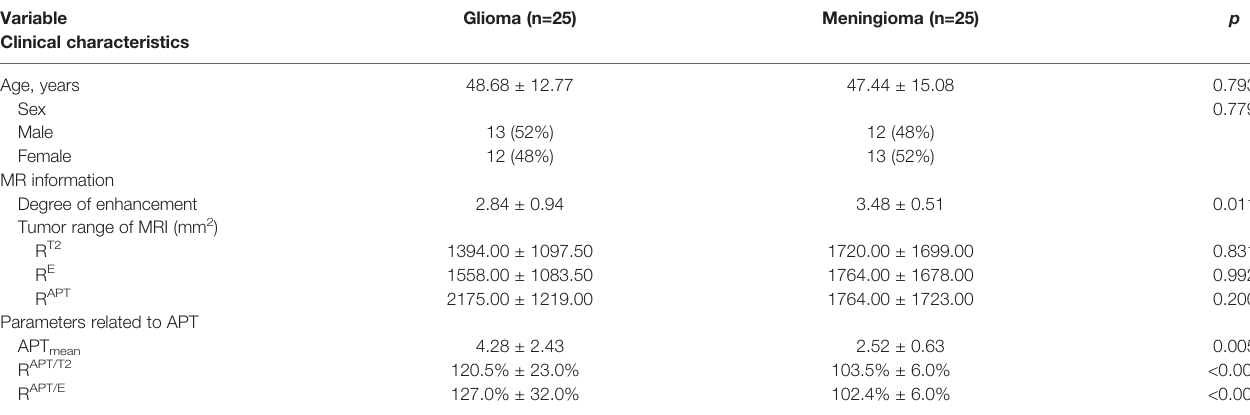
TABLE 1 | Clinical characteristics, tumour range of MR imaging and parameters related to APT based on differences in patients with glioma and meningioma.